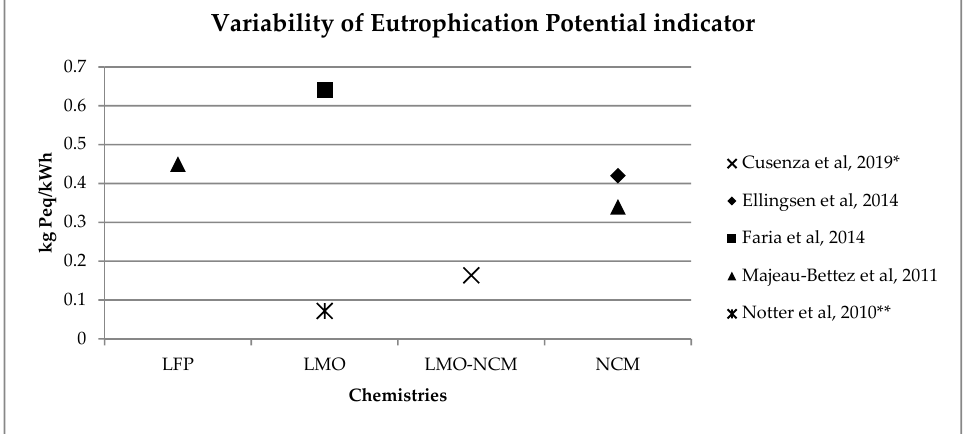
Figure 5. Variability of eutrophication potential (kg Peq/kWh) for batteries production phase (LFP: Lithium iron phosphate; LMO: Lithium Manganese Oxide; LMO-NCM: Lithium Manganese Oxide-Lithium Nickel Cobalt Manganese; NCM: Lithium Nickel Cobalt Manganese Oxide); * data from reference [7] are calculated on the basis of the total amount and the percentage for battery production, ** data from reference [11] have been updated using Ecoinvent v 3.5.